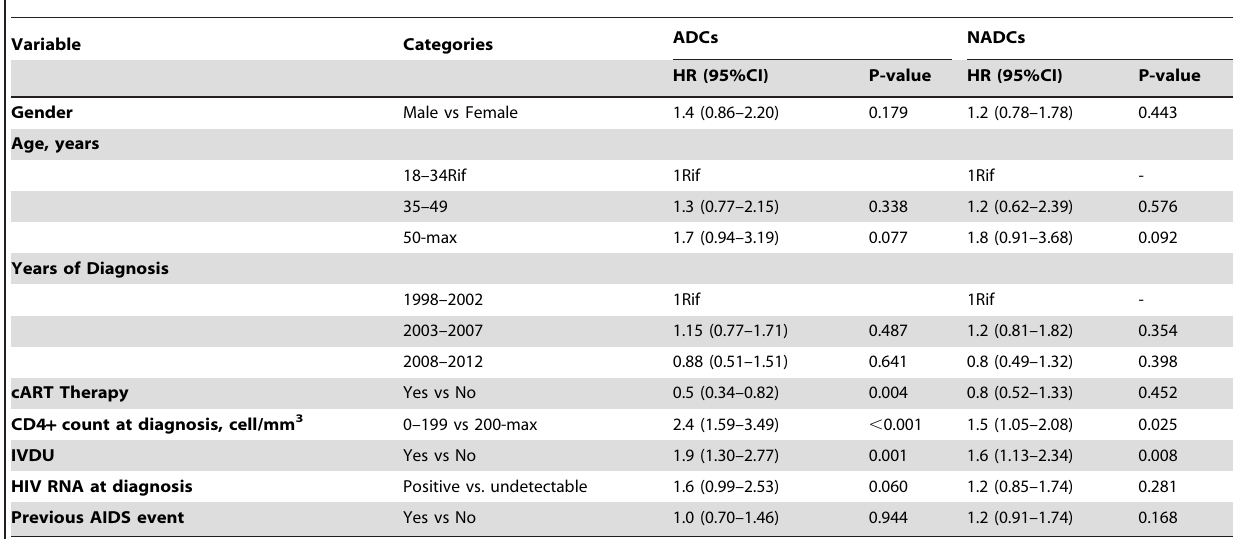
Table 4. Cox regression multivariate models for ADCs and